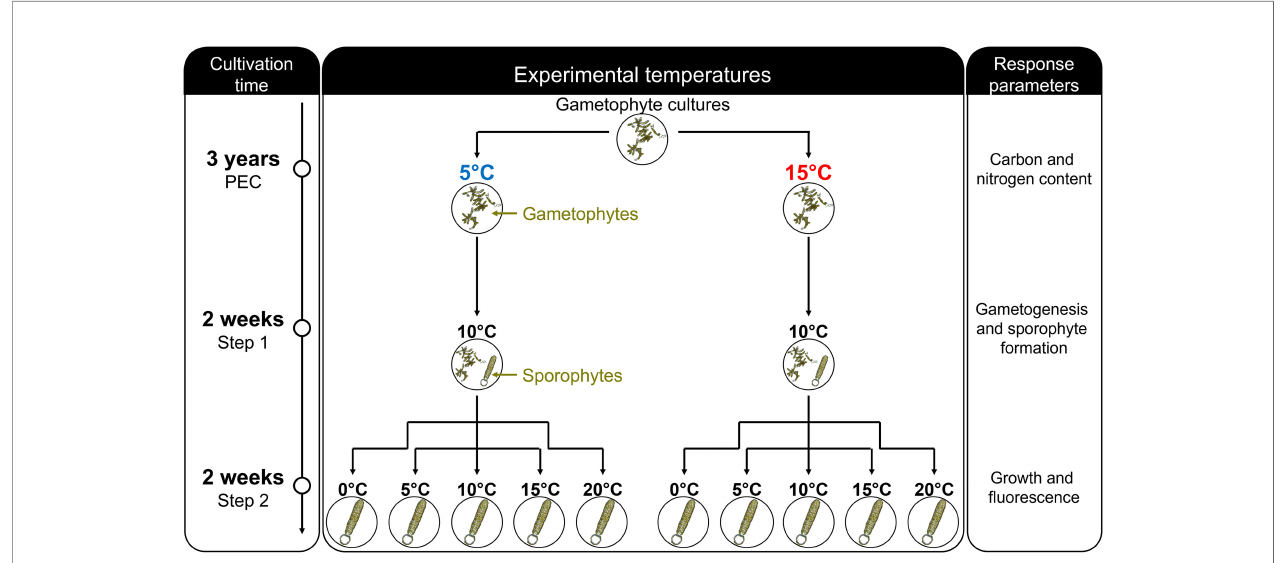
FIGURE 1 | Scheme of the two-step common garden experiment to investigate the effects of pre-experimental cultivation (PEC) across haploid gametophyte parents and diploid sporophyte offspring. Clonal gametophytes were cultivated for 3 years in parallel at 5°C and 15°C (pre-experimental cultivation), after which carbon and nitrogen contents of gametophytes were measured. Gametogenesis was induced simultaneously in both sets of gametophytes at 10°C for two weeks, during which gametogenesis and sporophyte formation were assessed (step 1). Differences in thermal tolerance of the resulting sporophytes were then investigated by measuring sporophyte growth and chlorophyll fl uorescence in a temperature gradient spanning 0 – 20°C over two weeks (step